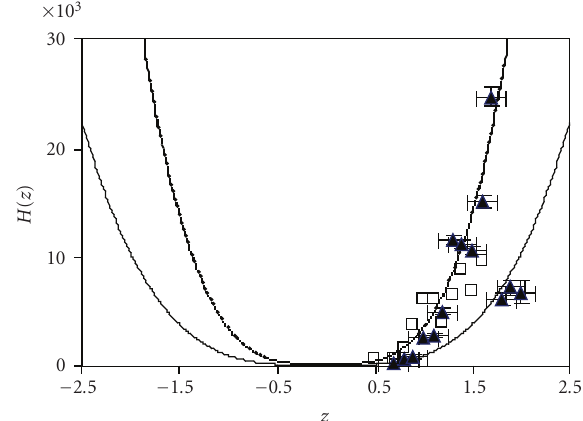
Figure 1: Probability density of hurricanes H ( z ) (times 1000) computed from storm data in the Asian Pacific basin for the period 1960–2007 shown as a function of the variable z defined in terms of the sea surface temperature T and the latitude φ according to z = ( T − T 0 )sin 1 / 2 | φ | with T 0 = 25 . 5 ◦ C, and with Southern Hemisphere data artificially displayed as having negative z -values. H ( z ) represents the probability of having a storm per month for a given z -interval. The size of the horizontal and vertical error bars is discussed in the text. The data is consistent with the n = 3 . 5 power law curve.